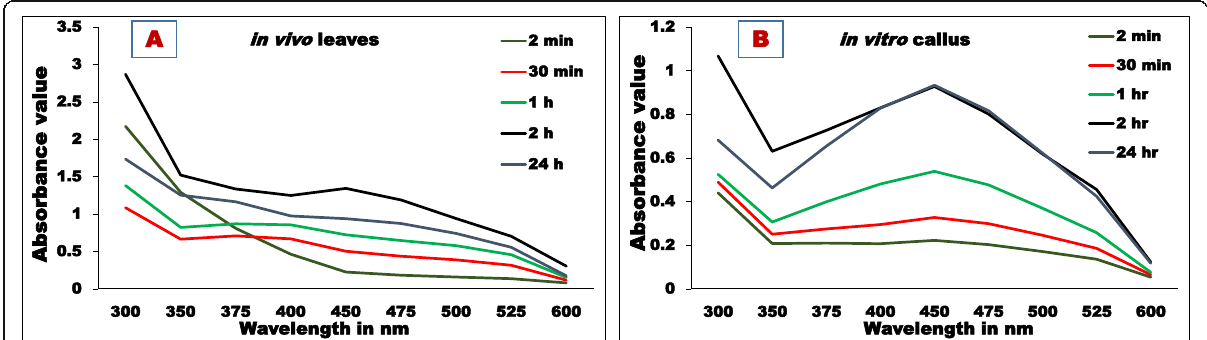
Fig. 3 The UV-visible spectra of AgNPs synthesized from CP in vivo leaves and in vitro-derived callus were recorded after time intervals of 2 min, 30 min, 1 h, 2 h, and 24 h from the beginning of the reaction in a leaf extract, b callus extract